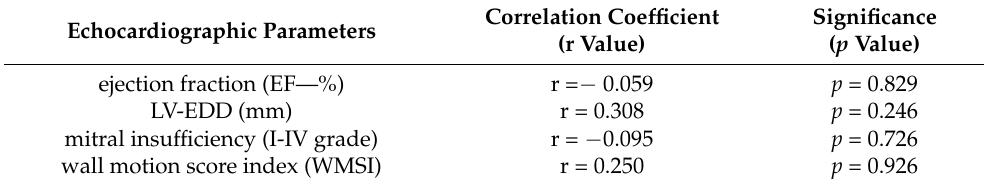
Table 3. Correlation between the different echocardiographic parameters and the plasma PACAP levels.